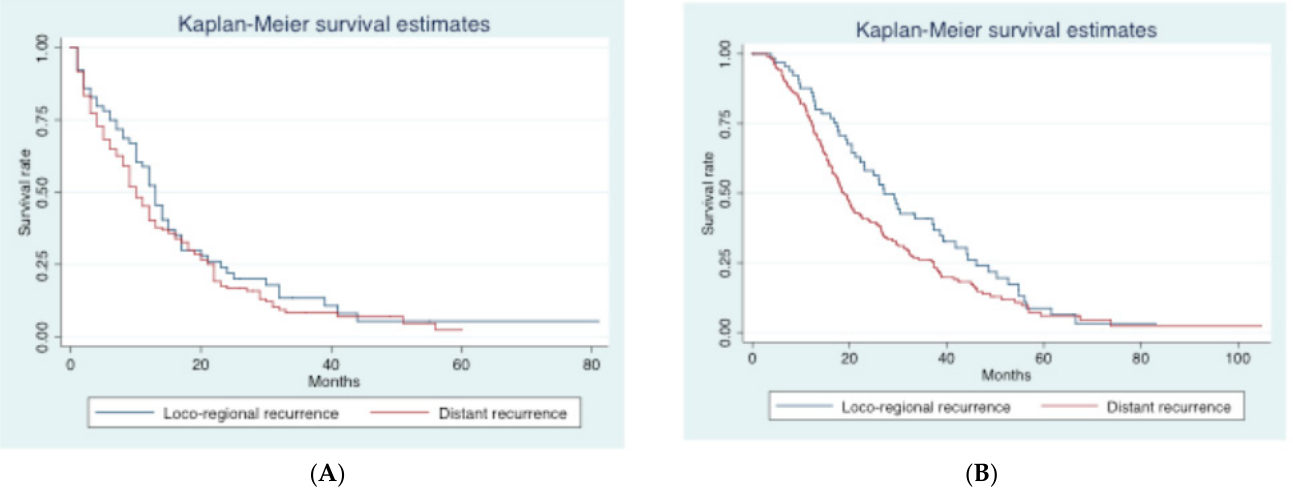
Figure 1. Kaplan–Meier curves according to the site of recurrence (loco-regional vs distant). ( A ). Post- progression survival (PPS) curves according to the site of recurrence. ( B ). Overall survival (OS) curves according to the site of